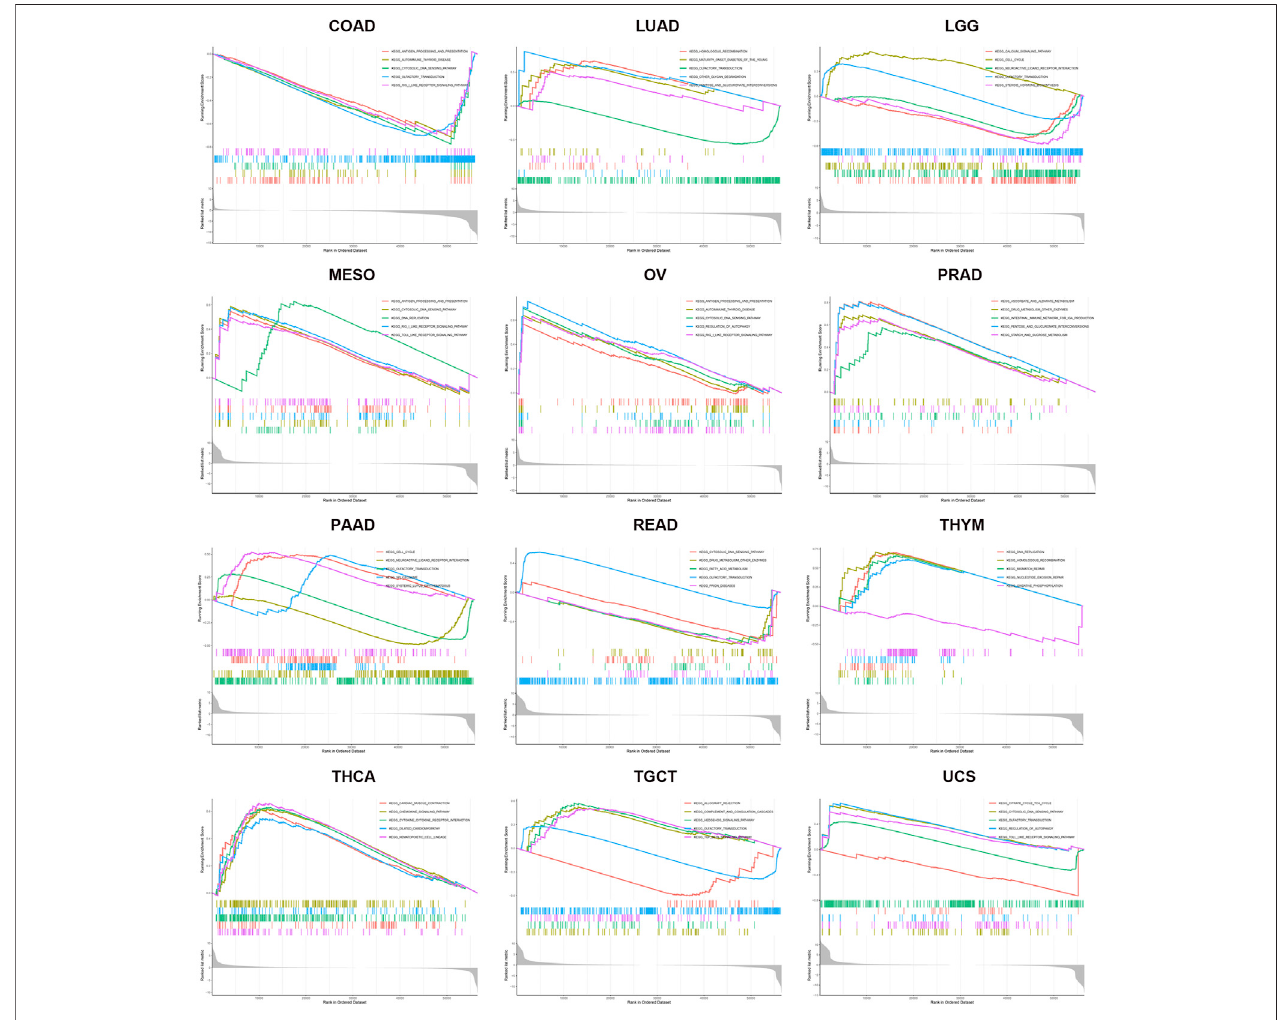
FIGURE 8 | KEGG enrichment analysis of KIF18B in various cancers. Values of p < 0.05 and results higher than 5 were considered and